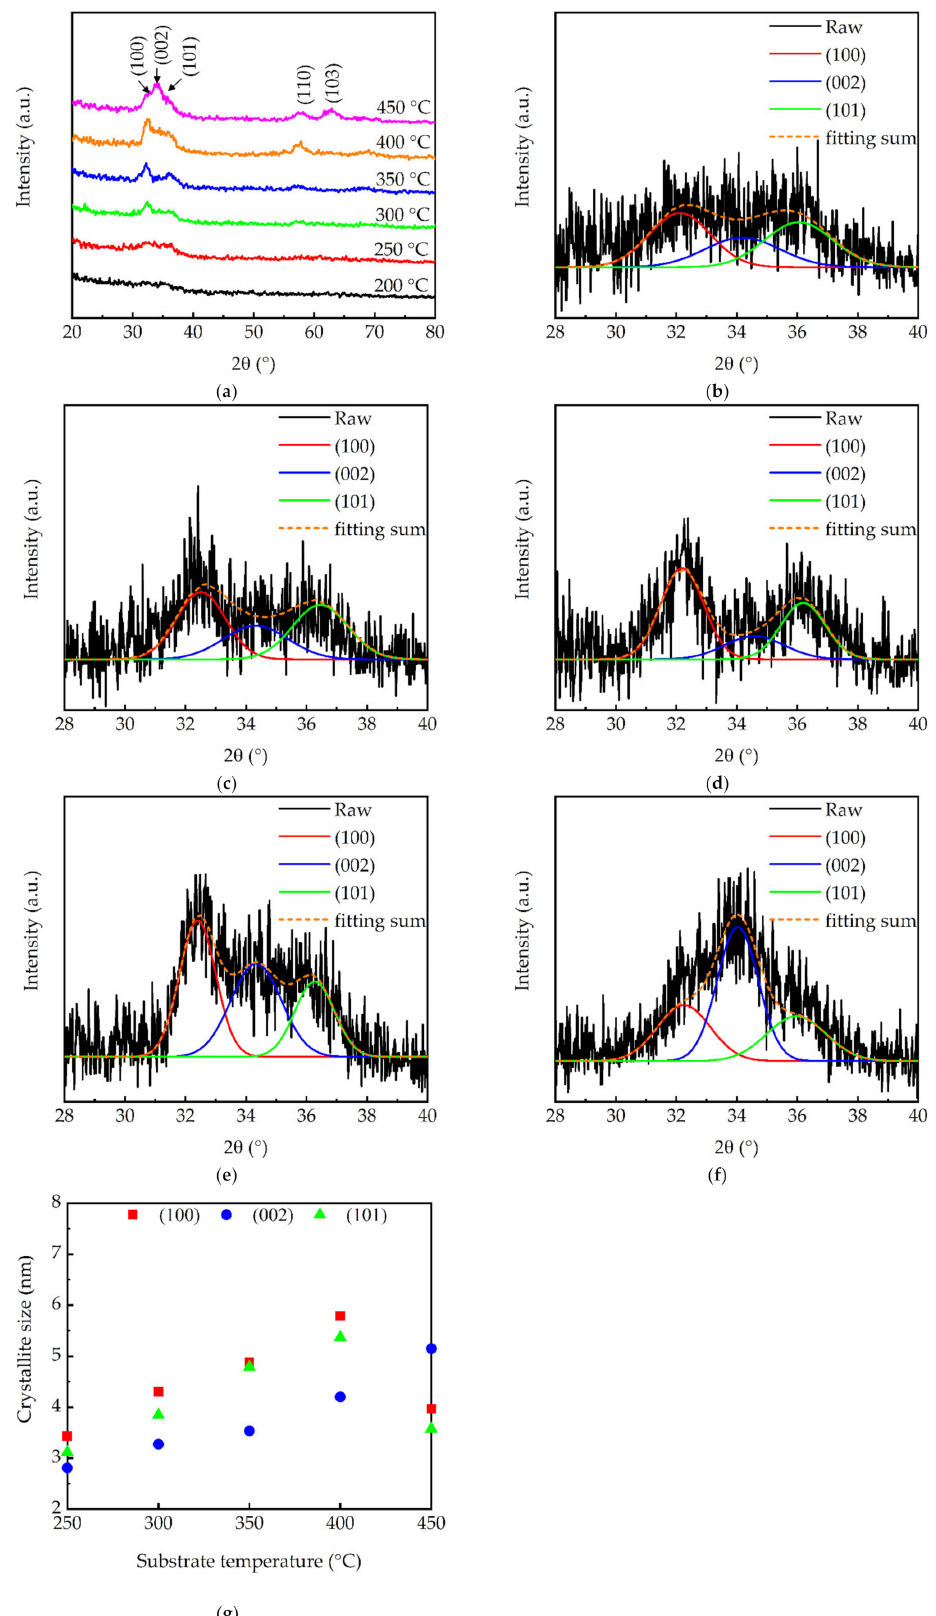
Figure 3. ( a ) GIXRD patterns of the GaN films with different substrate temperatures. The spectra have been vertically shifted for clarity. Peak deconvolution for the films prepared at ( b ) 250, ( c ) 300, ( d ) 350, ( e ) 400, and ( f ) 450 ◦ C. ( g ) Crystallite size for GaN (100), (002), and (101)